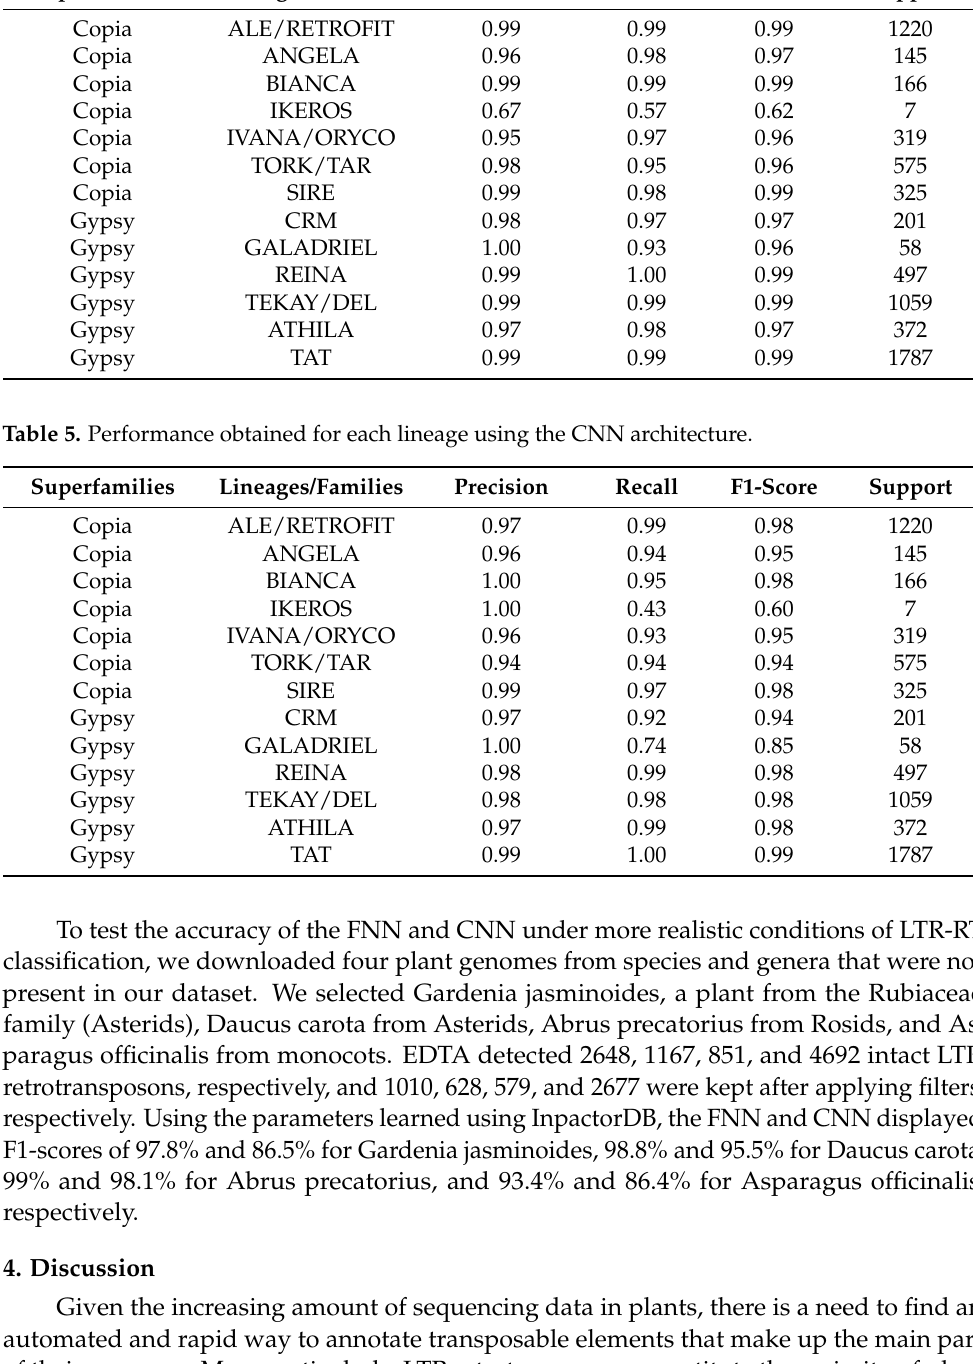
Table 4. Performance obtained for each lineage using the FNN architecture. Superfamilies